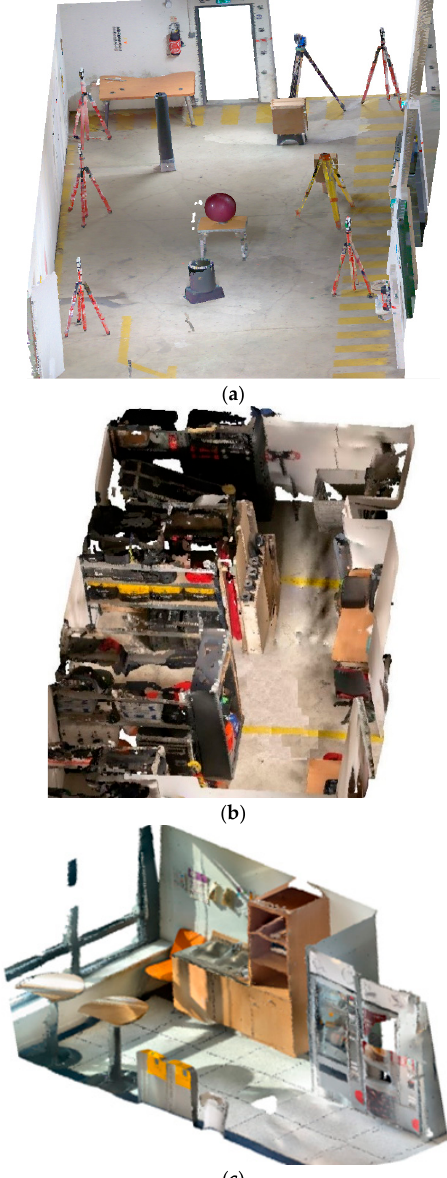
Figure 8. Perspective image of the meshed point cloud for ( a ) the parking, ( b ) the warehouse, and ( c ) the local. Phase 4: Cloud-to-cloud comparison of FARO vs LiDAR smartphone data: